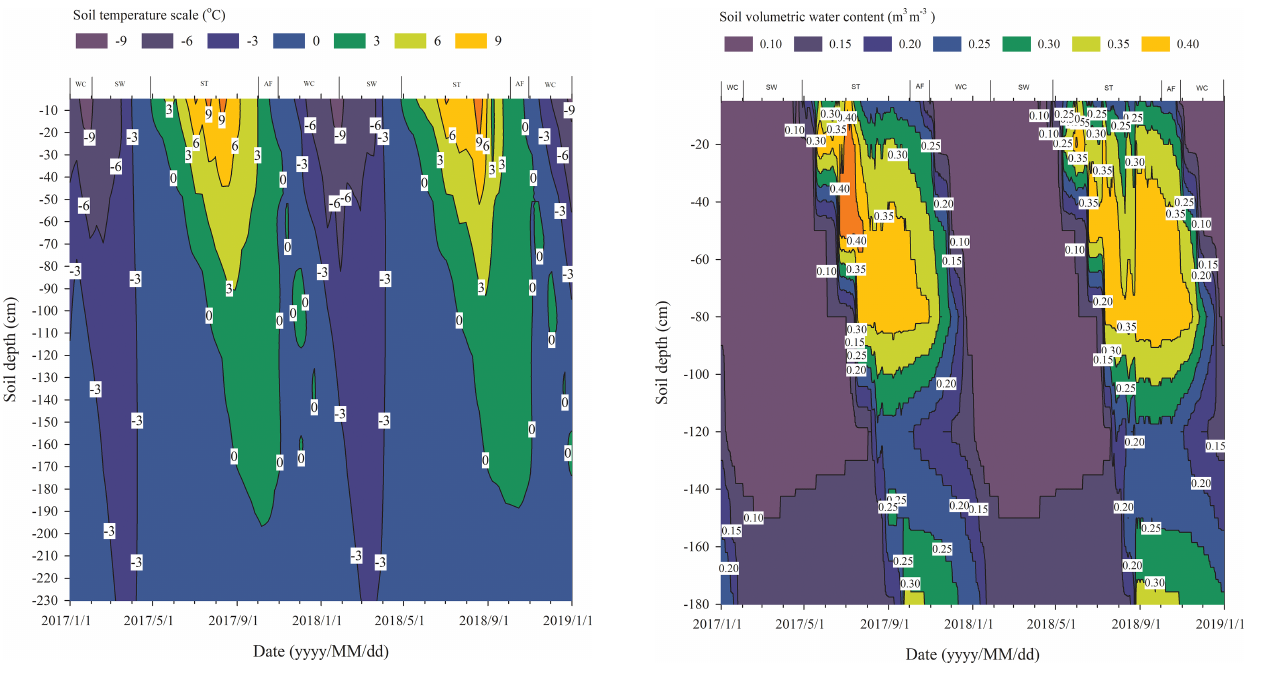
Figure 2. Soil moisture contour outlines of the experimental site in 2017 and